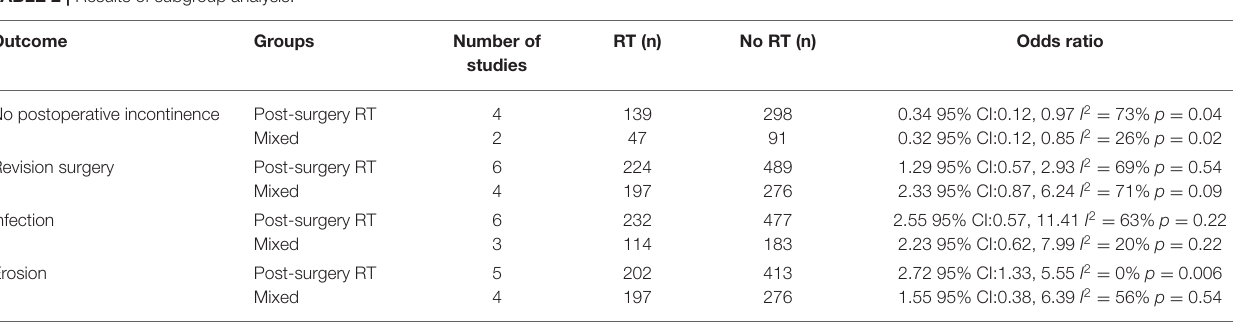
TABLE 2 | Results of subgroup